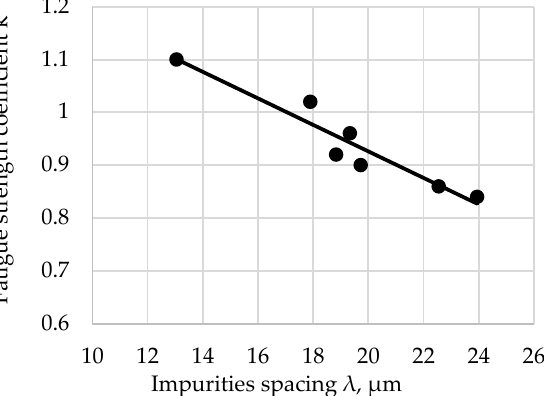
the tested steel. in